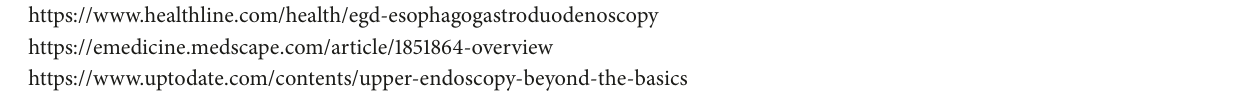
Table 4: Websites found to have adequate content on